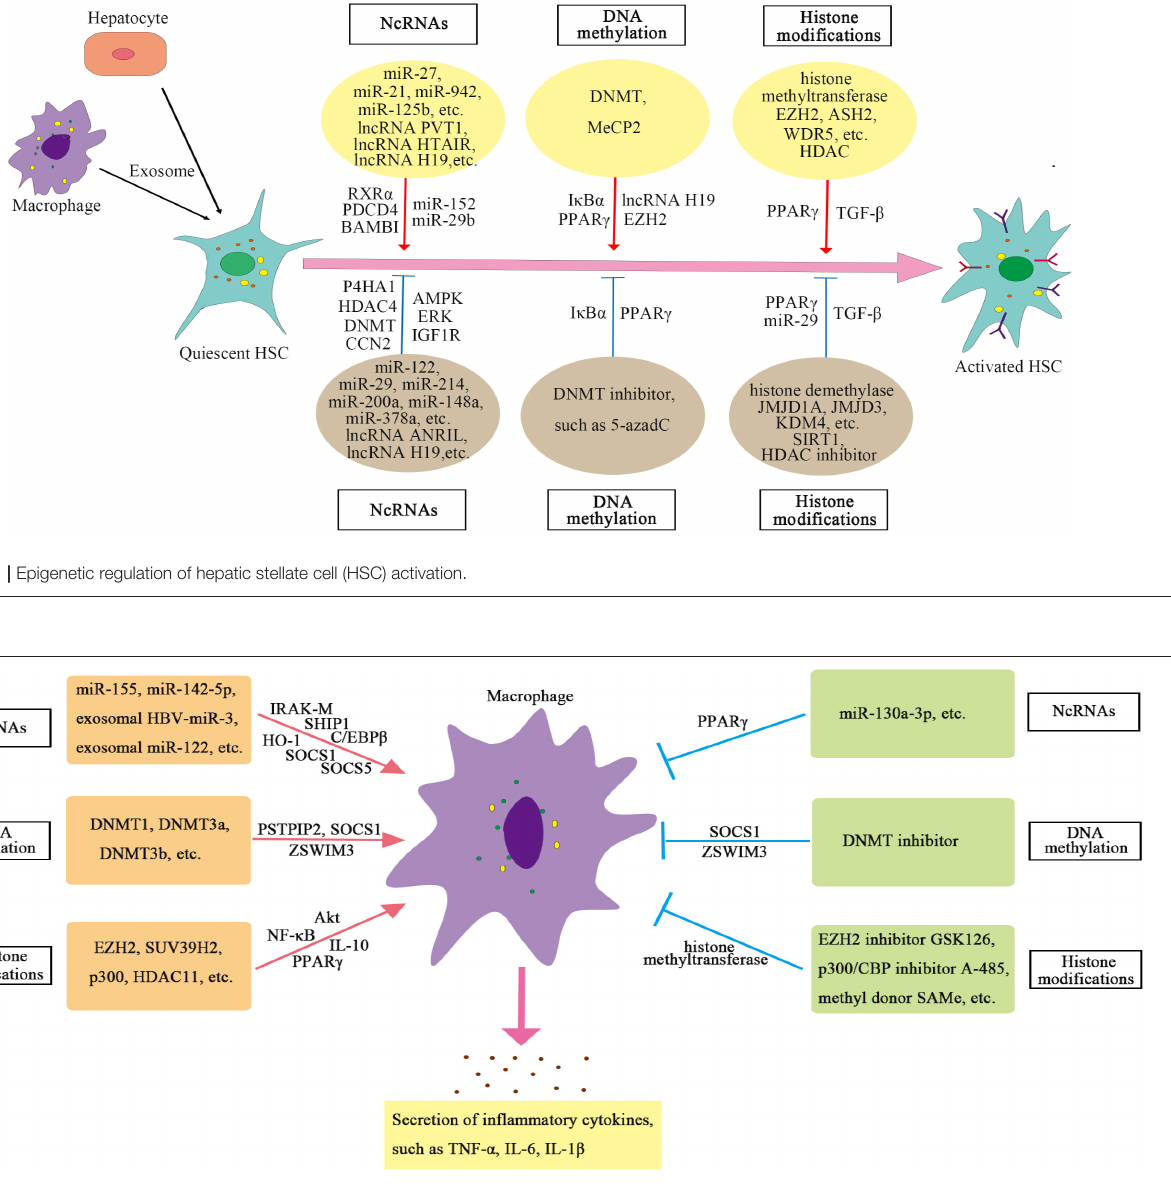
FIGURE 2 | Epigenetic regulation of hepatic